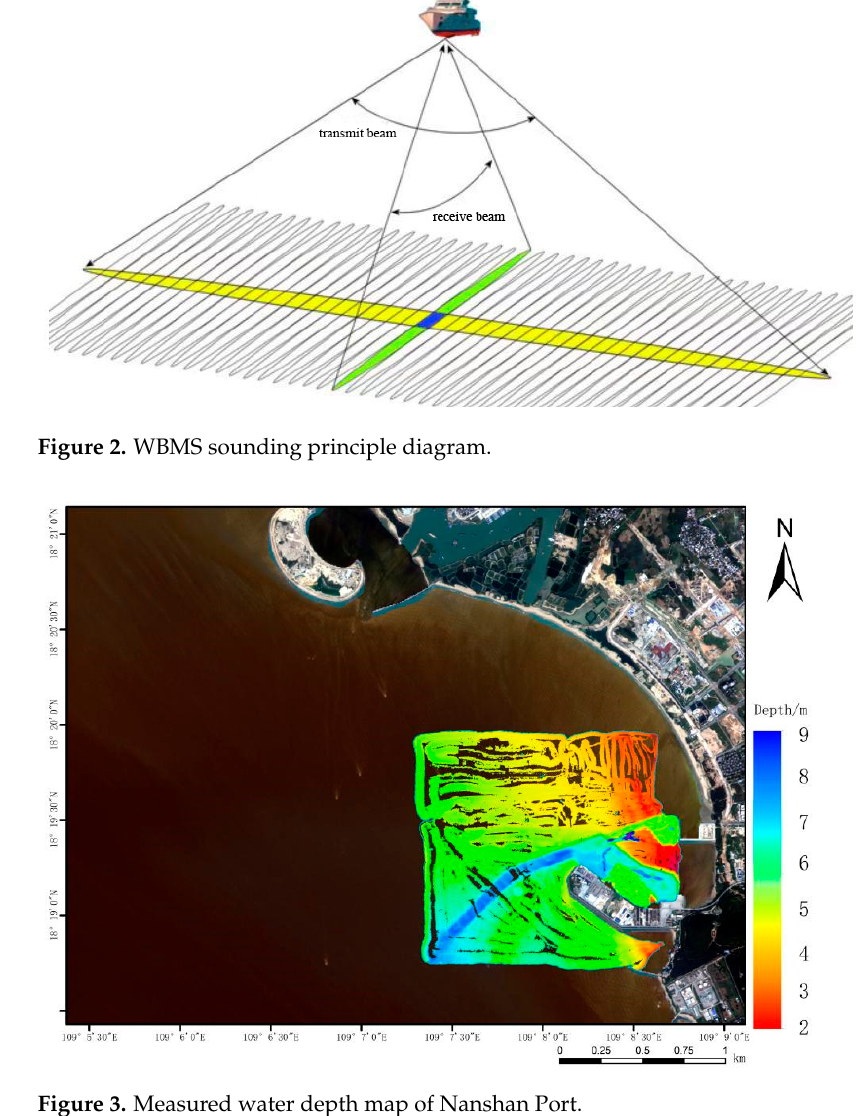
Figure 2. WBMS sounding principle diagram.